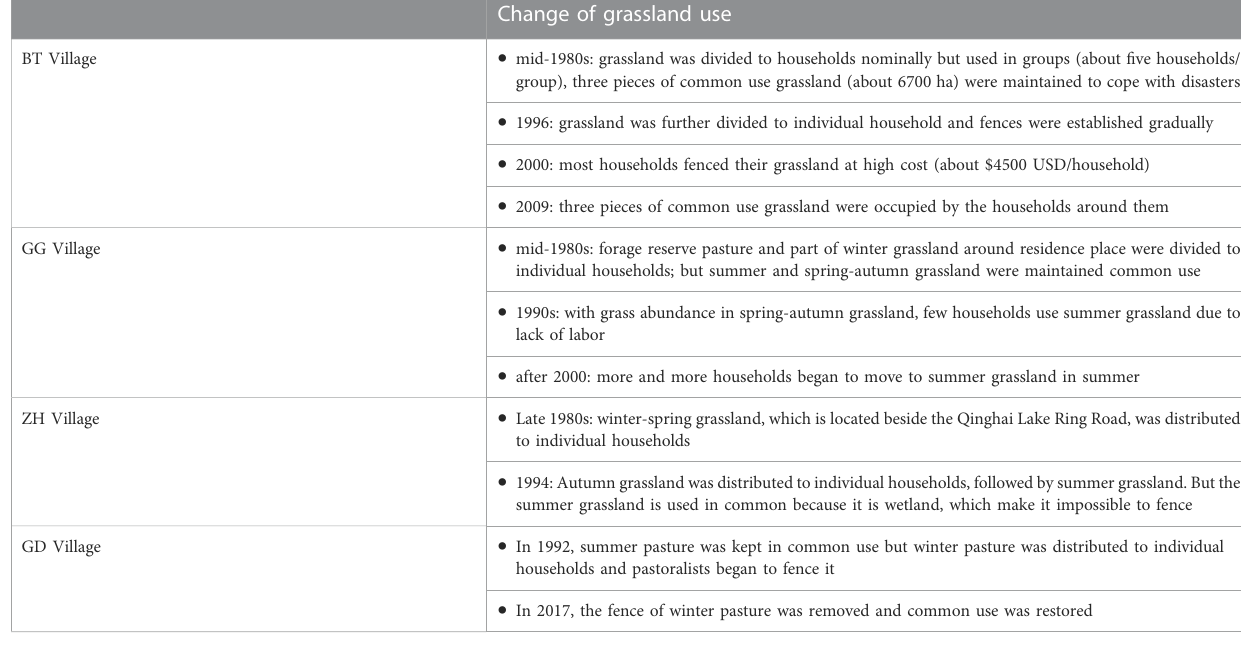
Change of grassland use